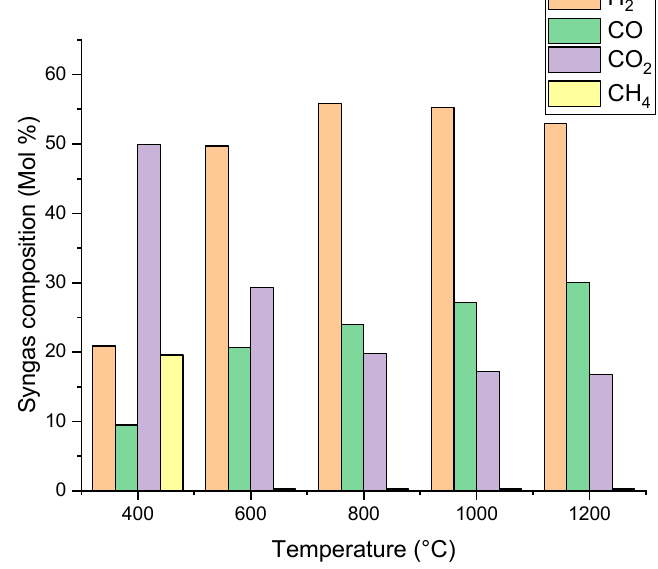
Figure 2. E ff ect of gasifier temperature on syngas Figure 2. Effect of gasifier temperature on syngas composition.